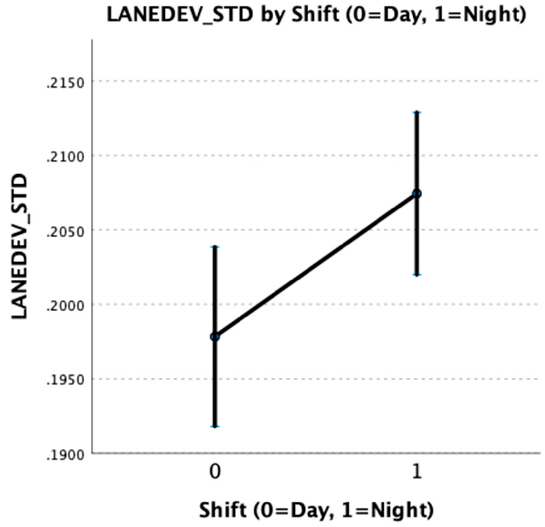
Figure 2. Standardized lane deviation (LANEDEV_STD) by participant work shift.